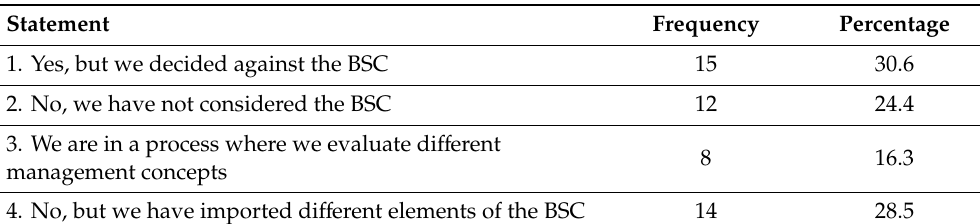
Table 9. Prior consideration of the BSC (N = 49).